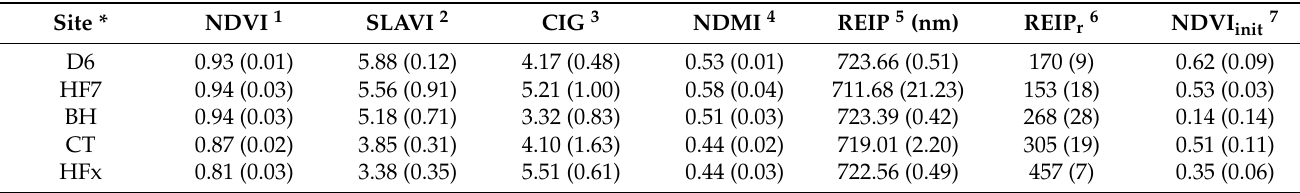
Table 3. Means and standard deviations (in parentheses) of the peak values of vegetation indices during the potato production season.